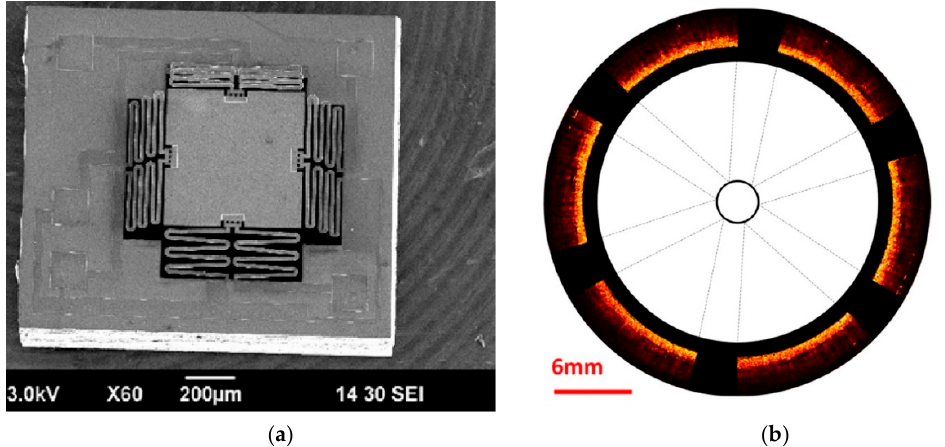
Figure 24. An SEM image of the MEMS mirror in ( a ) and the imaging sample of a swine’s small intestine covering a glass tube in ( b ) (Figures from [66]).